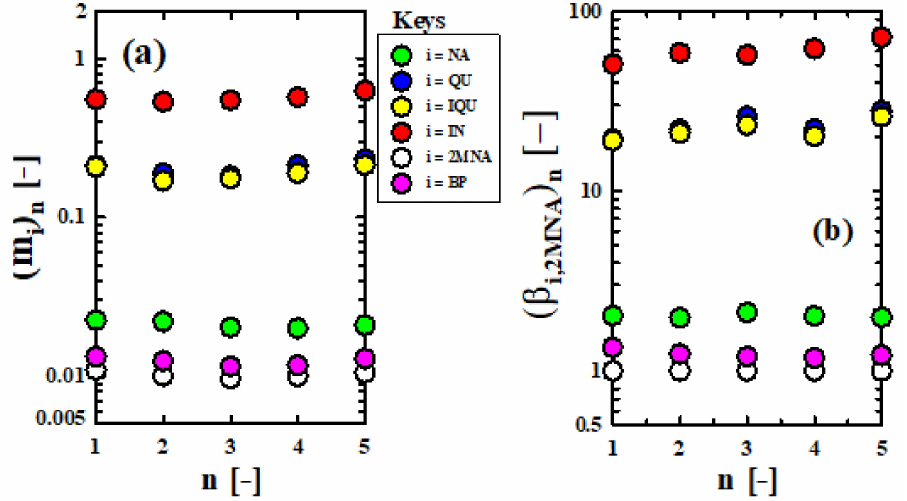
Figure 4. Changes in ( a ) (m i ) n and ( b ) ( β i,2MNA ) n according to number of equilibrium extractions (n). Experimental conditions: y w,0 = 0.05, S 1 /R 0 = 1, T = 30 ◦ C, t = 72